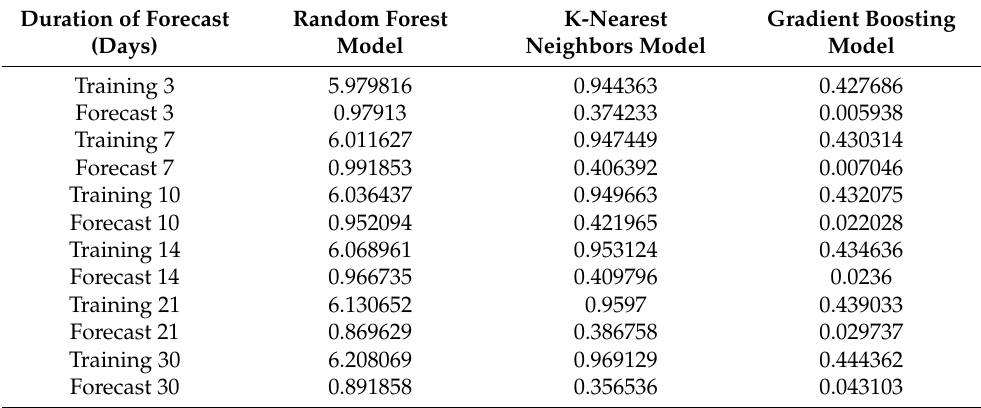
Table 3. Relative error of forecasted new cases for South Korea (%).